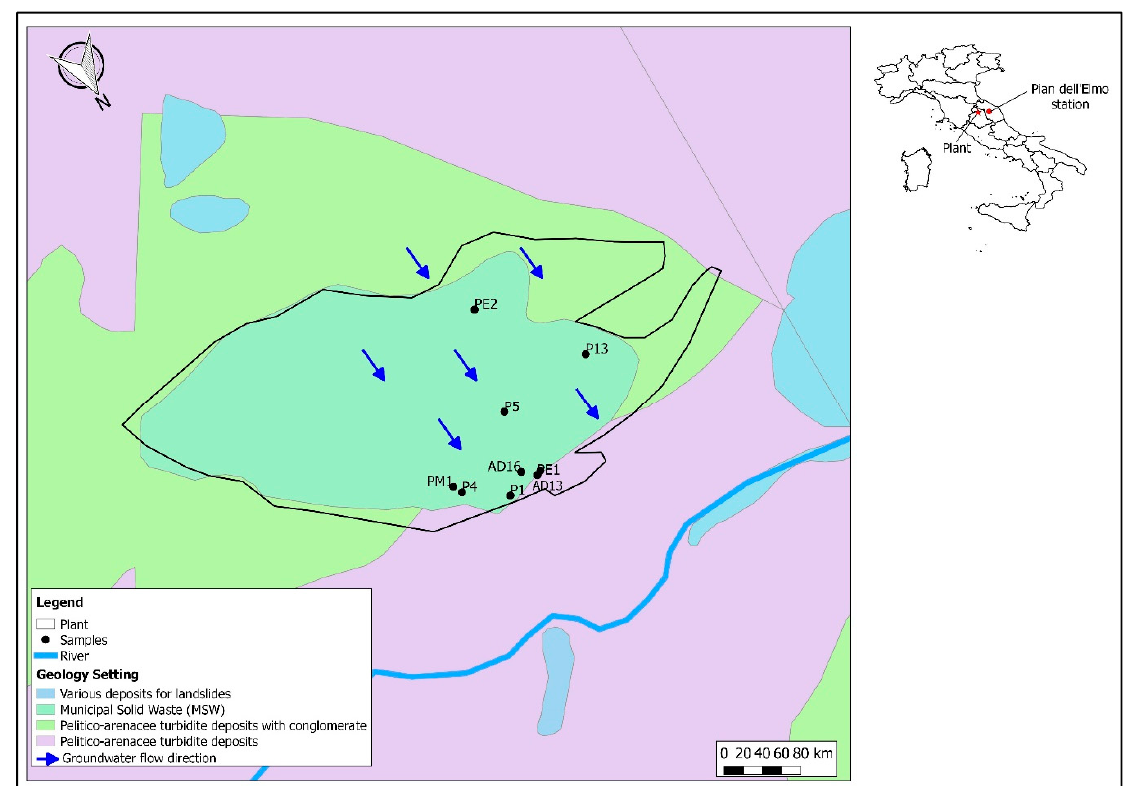
Figure 3. Geological Setting Case History II.